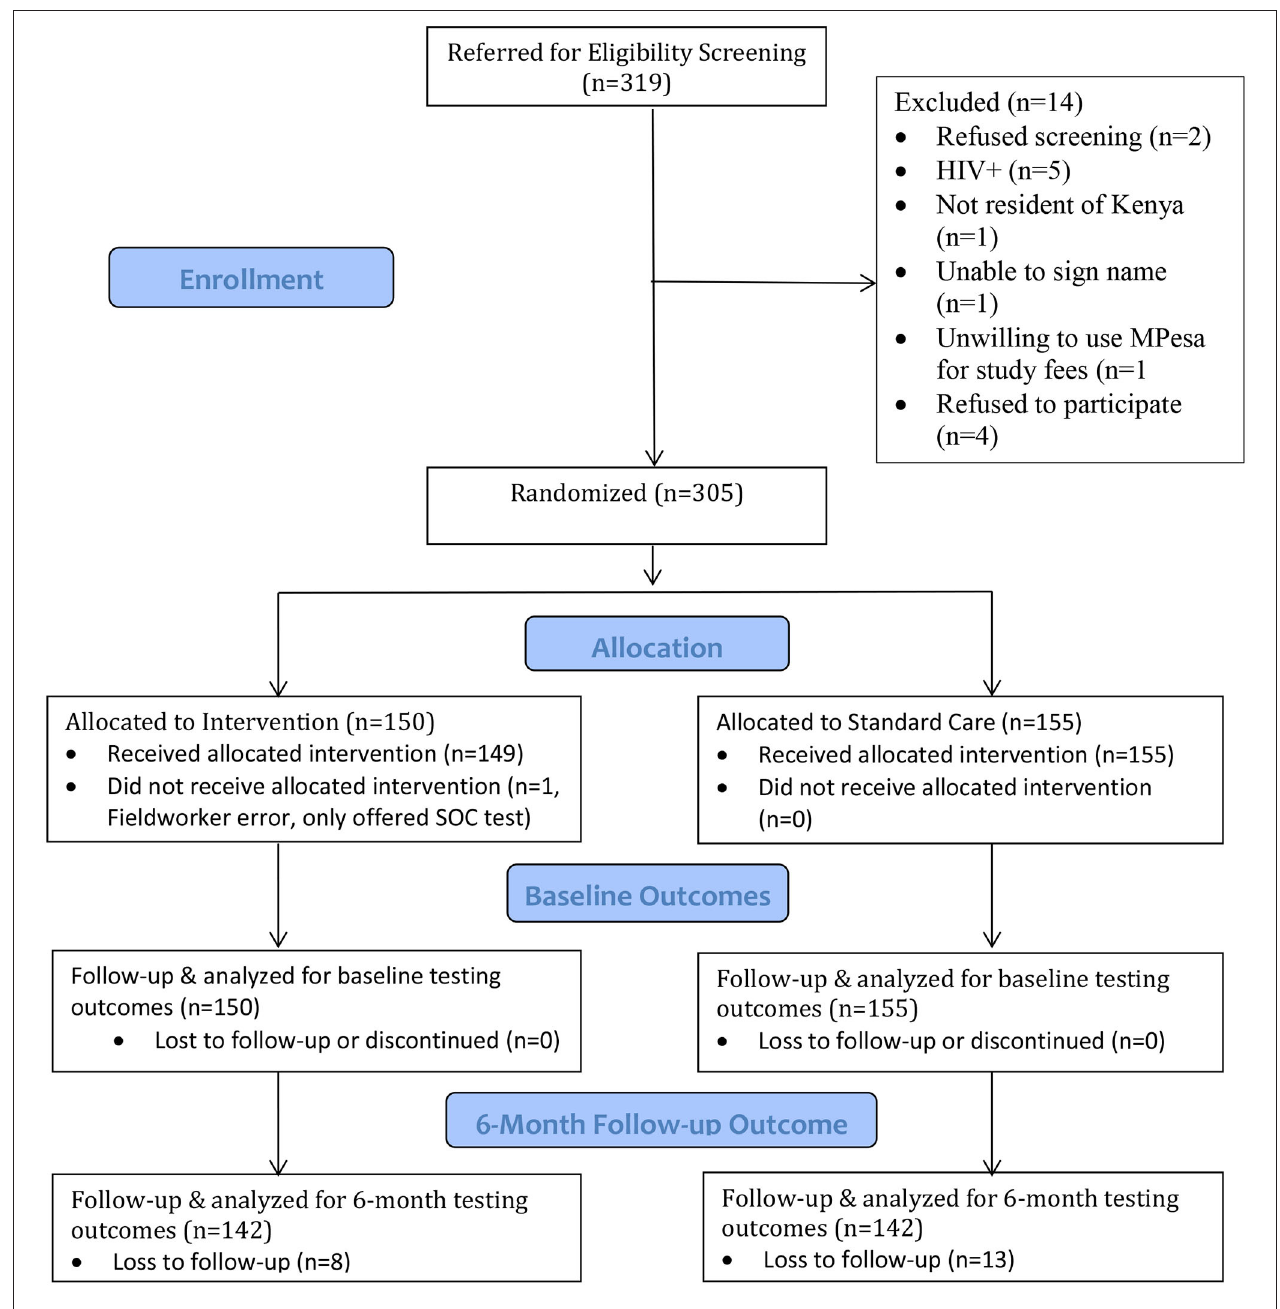
FIGURE 1 | Study flow